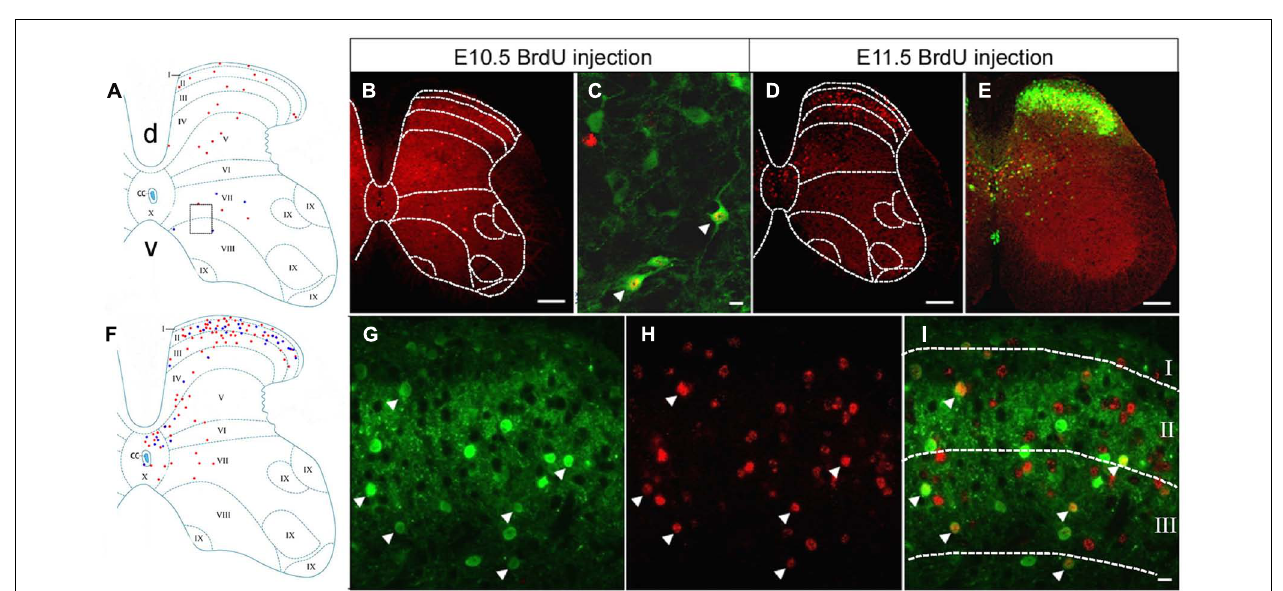
FIGURE 1 | Double-labeling of GFP (green) and BrdU (red) in the spinal cord of the GAD 67 -GFP knock-in mice following injection of BrdU at E10.5 and E11.5. (A,F) Schematic drawings showing the distribution of BrdU-positive cells and double-labeled neurons in the lumbar spinal cord, taken from P60 mice that had received a single pulse of BrdU at E10.5 (A) and E11.5 (F) . (A) The schematic drawing represents a single section and it corresponds to the same section illustrated in (B) . (F) The schematic drawing represents a single section and it corresponds to the same section illustrated in (D) . Red circles correspond to BrdU-positive cells and blue circles correspond to double-labeled neurons. (B) Note the distribution of BrdU-positive cells after injection of BrdU at E10.5. (C) Higher magnification